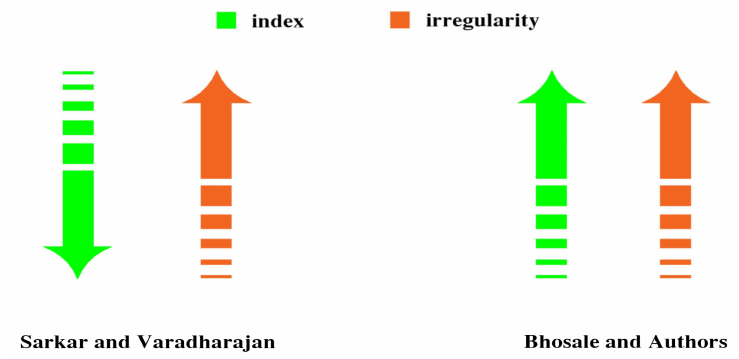
Figure 14. The relation between the index and irregularity of the building.